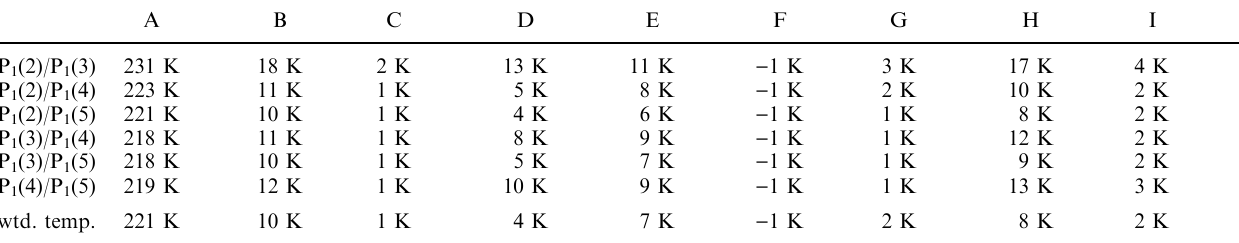
Table 3. Average temperatures and uncertainty estimates for individual ratios and the weighted temperature (see text) for the principal data set. (A) average temperatures; (B) standard deviation; (C) standard error in mean; (D) average ‘counting error’ for individual spectra;